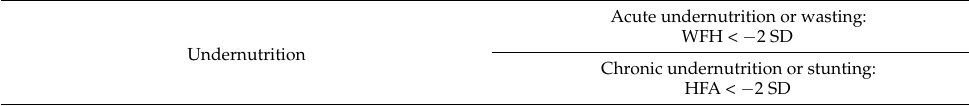
Table 1. Definition of undernutrition in children